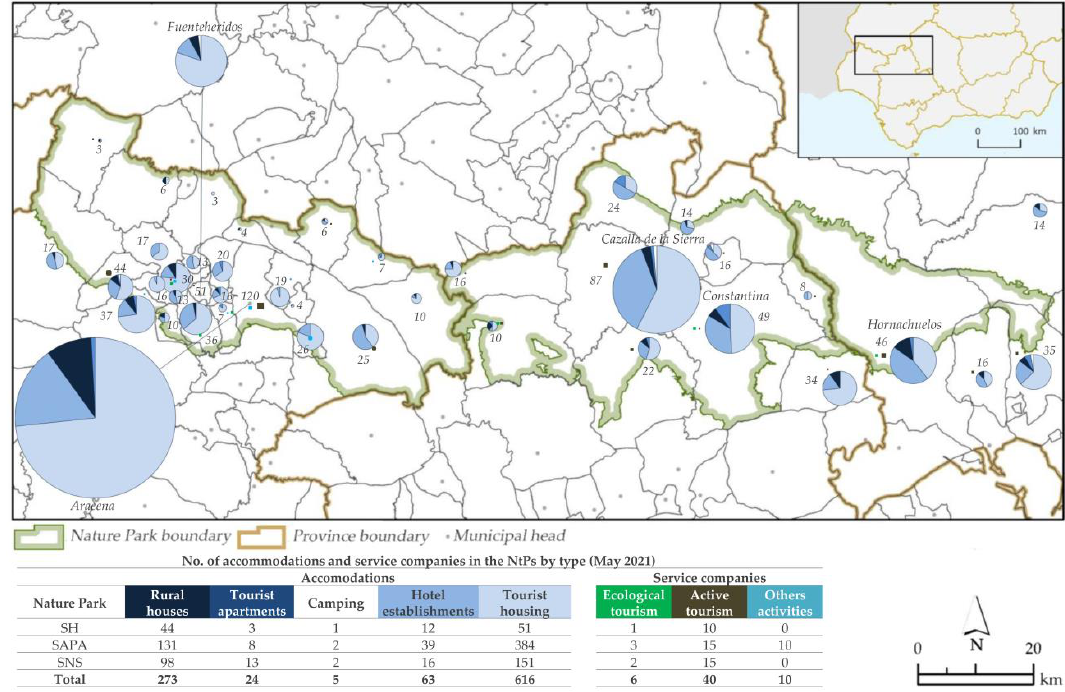
Figure 21. Tourist activities by type in the study area (2021). Source: [79]; authors ’